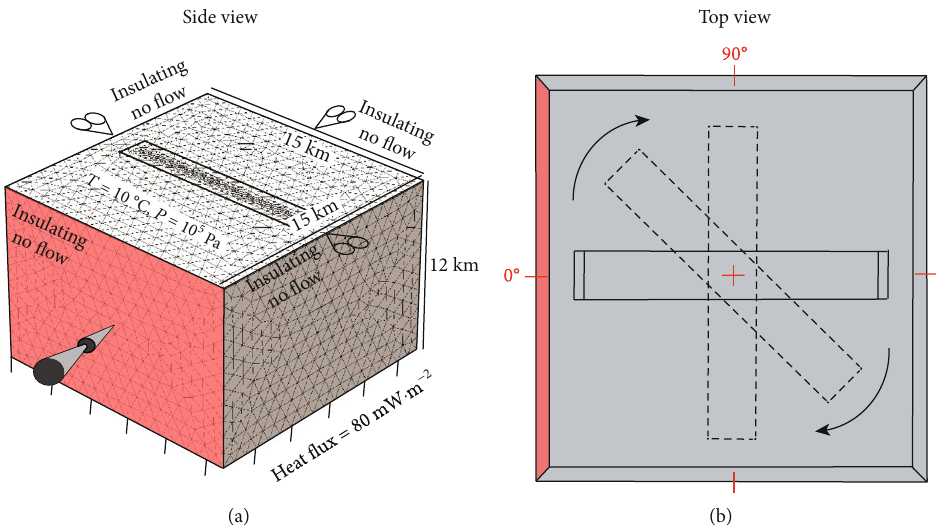
Figure 4: Geometry, meshing, and boundary conditions of the parametric study. Numerical set-up is detailed in the